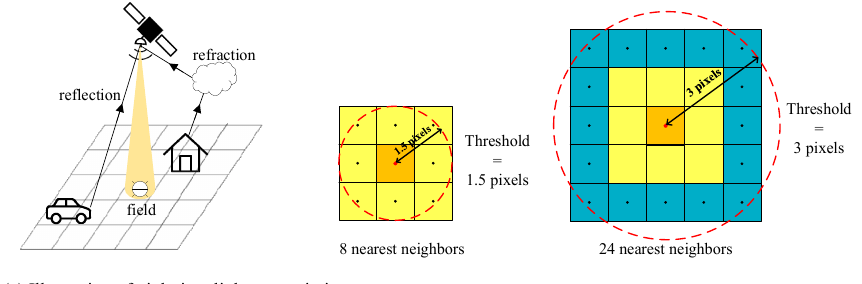
Figure 3. Spatial weight matrix setting.